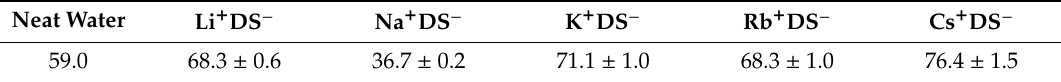
Table 1. Surface tension of the five alkali dodecyl sulfate solutions, as obtained from our simulations. The value obtained for neat water is also included for comparison. All values are in mN / m